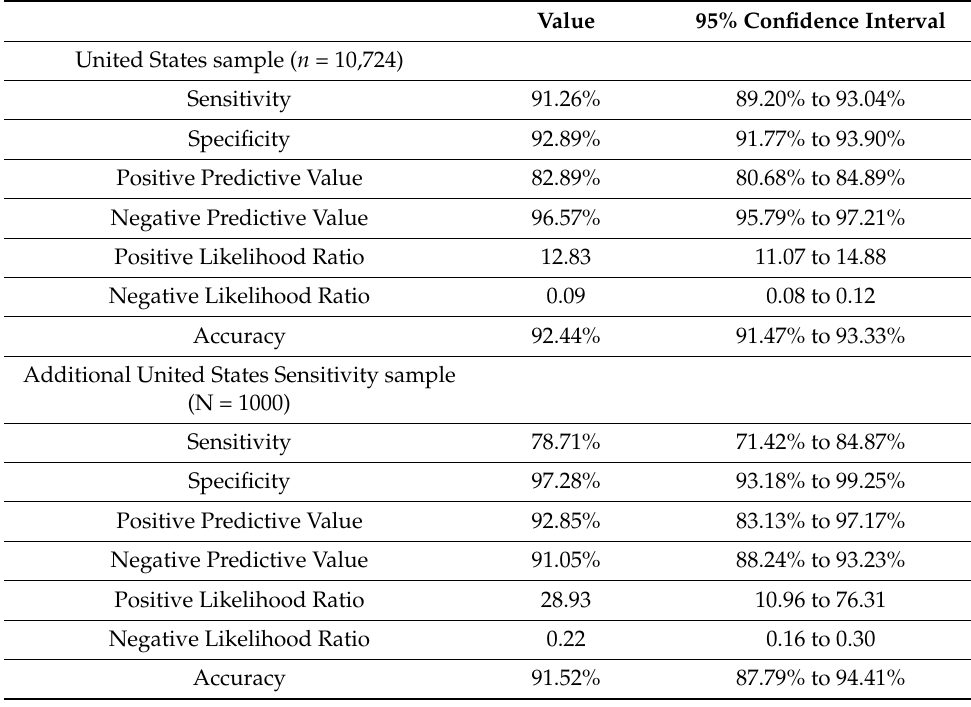
Figure 3. Number of BREESI items endorsed for low ( not suggestive ) versus high ( very suggestive ) QEESI chemical intolerance categories. Figure 2 shows that as more BREESI items are chosen, the percentage having QEESI-defined CI (solid black bars) increases. As fewer BREESI items are chosen, a much lower percentage of very suggestive of CI is observed. Table 4. Statistical performance metrics of the